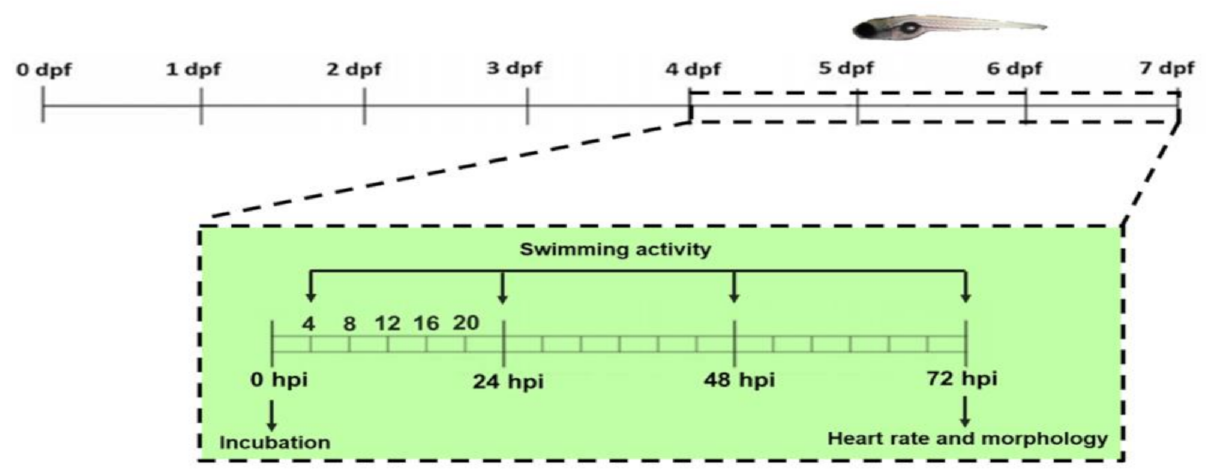
Figure 11. Timeline of zebrafish development in days post-fecundation (dpf). The inset shows the time in which determina- tions were carried out in dpf and hours post-incubation (hpi).